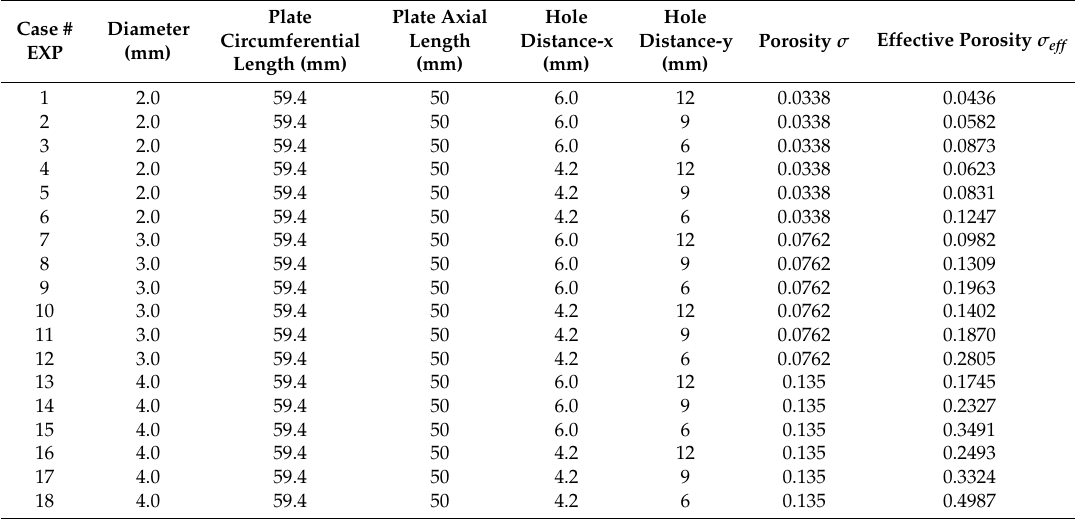
Table 2. Geometric details of perforated plates for experimental data